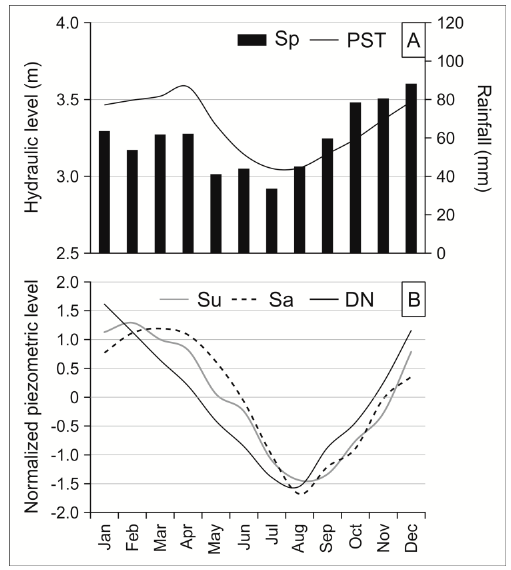
Figure 6. Monthly average: for rainfall and hydrometric level ( A ); and for normalized piezometric level ( B ), 1986–2009 period.